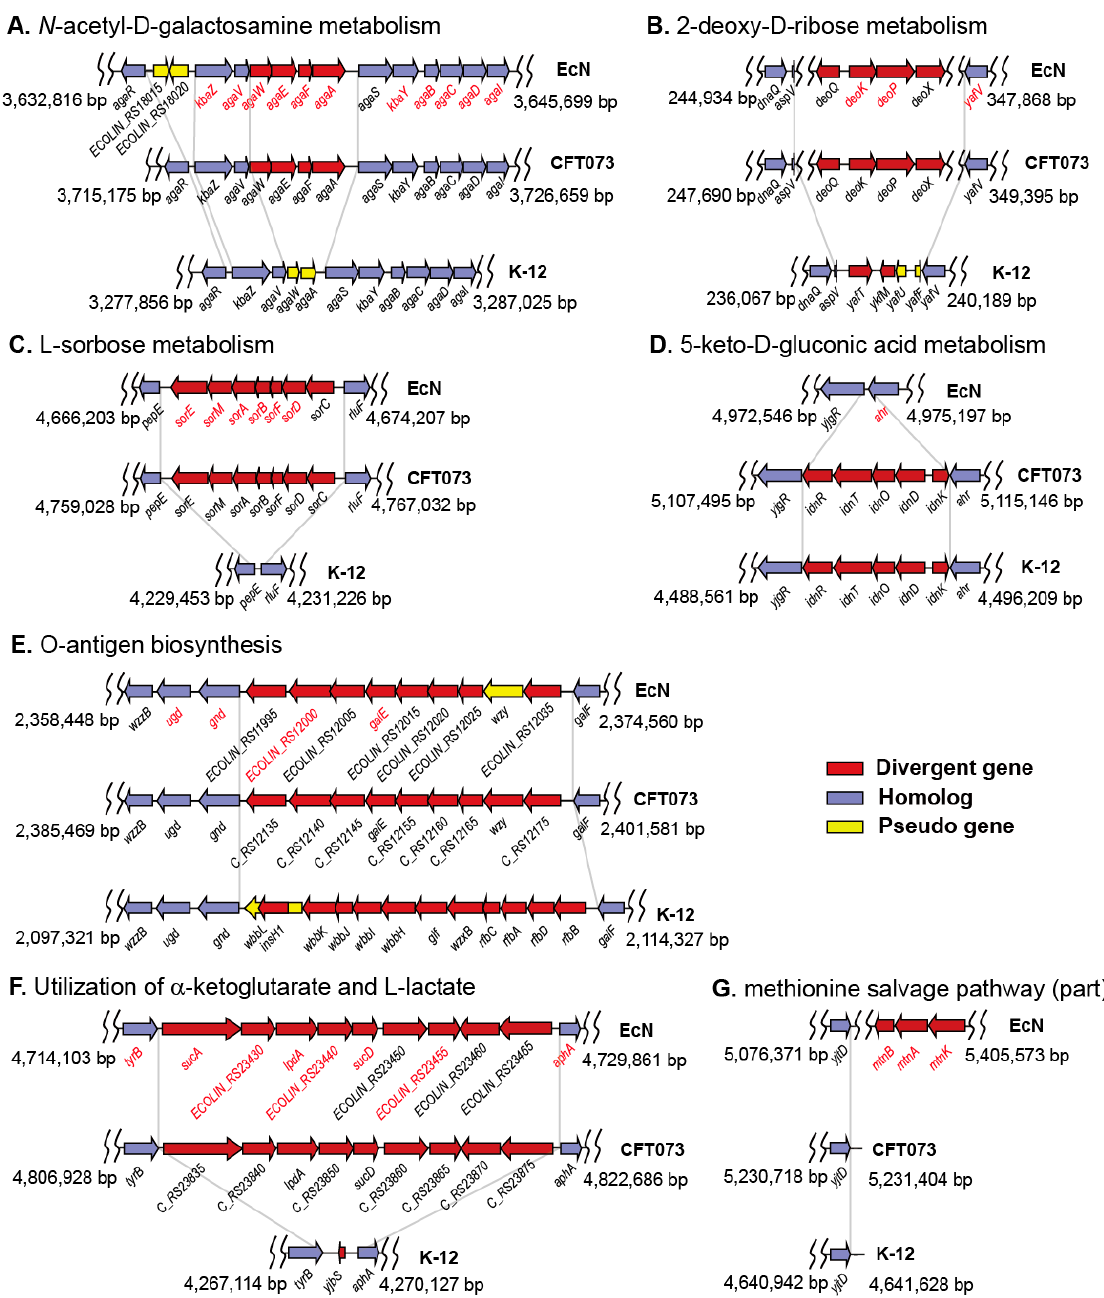
Figure 3. Examples of different metabolic gene clusters in the genomes of E. coli strains Nissle 1917, CFT073, and K-12 MG1655. Gene clusters for N -acetyl-D-galactosamine metabolism ( A ), 2-deoxy-D-ribose metabolism ( B ), L-sorbose metabolism ( C ), 5-keto-D-gluconic acid metabolism ( D ), O-antigen biosynthesis ( E ), anaerobic utilization of α -ketoglutarate (AKG) and L-lactate ( F ), and a part of methionine salvage pathway ( G ). Gene names in red are for Nissle genes, the reactions of which were included in the Nissle metabolic model.